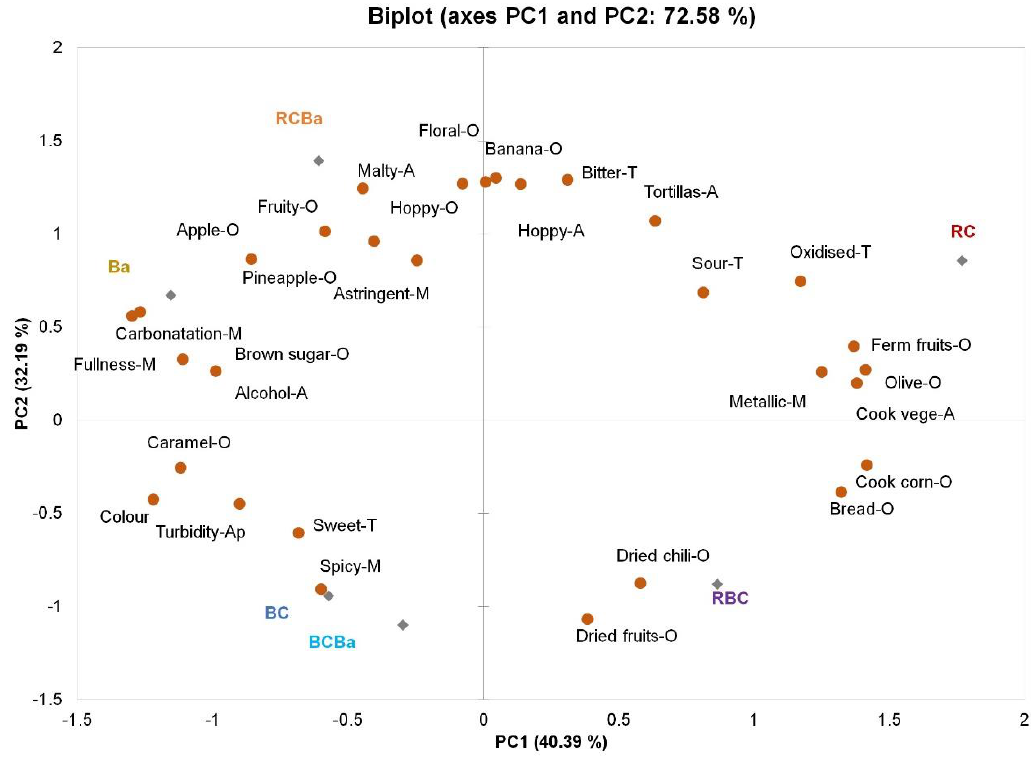
Figure 2. Principal Component Analysis (PCA) bi-plot of variables and individuals of descriptive sensory data. BC = 100% blue corn, RC = 100% red corn, RBC = 50:50 red and blue corn, Ba = 100% barley, BCBa = 50:50 blue corn and barley, RCBa = 50:50 red corn and barley. PCA permitted a clear-cut separation of the samples based on the type of malt